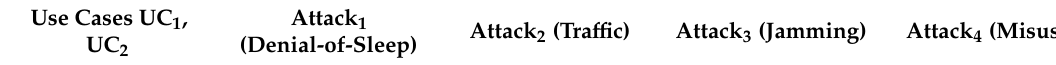
Table 5. Energy resources exhaustion (ERE) attack criticality.